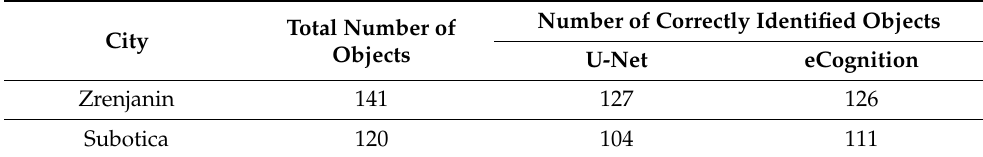
Table 2. Building identification results in test area.